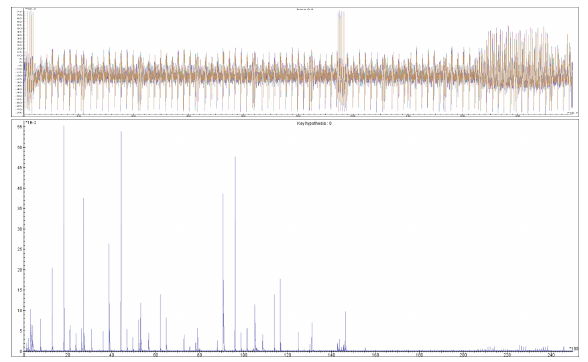
Figure 8: EM Campaign – SNR result for the seg (bottom) and original EM trace